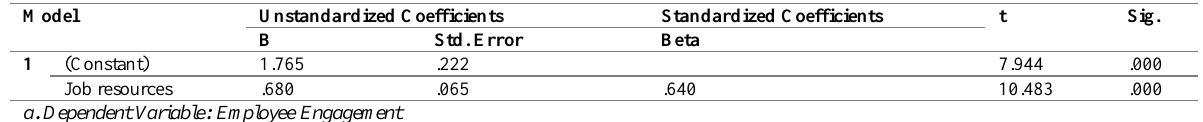
Table 4: Coefficients for job resources on work engagement